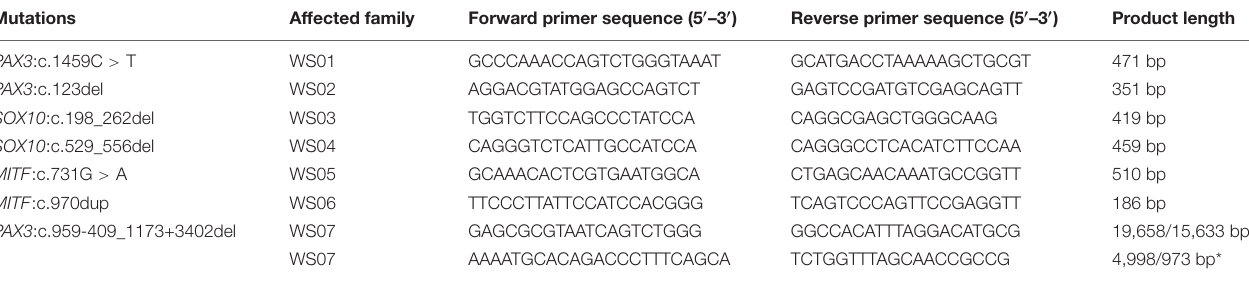
TABLE 2 | Primer pairs of the novel mutations of paired box 3 (PAX3), SRY-box transcription factor 10 (SOX10), and melanocyte inducing transcription factor (MITF). Mutations Affected family Forward primer sequence (5 (cid:48) –3 (cid:48) ) Reverse primer sequence (5 (cid:48) –3 (cid:48) ) Product length